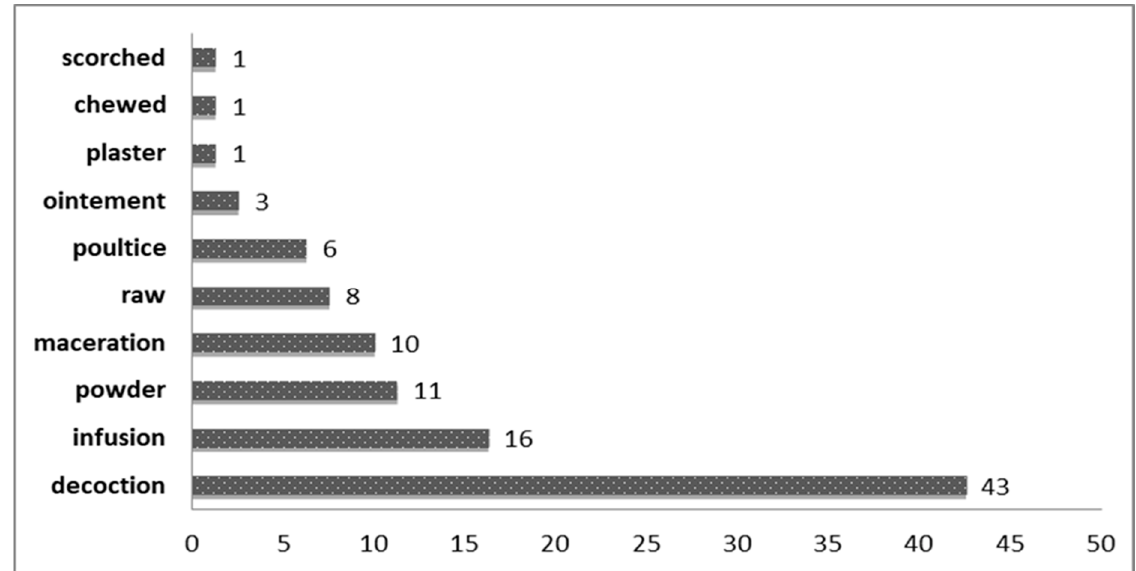
Figure 5. Use of reported ethnospecies according to method of